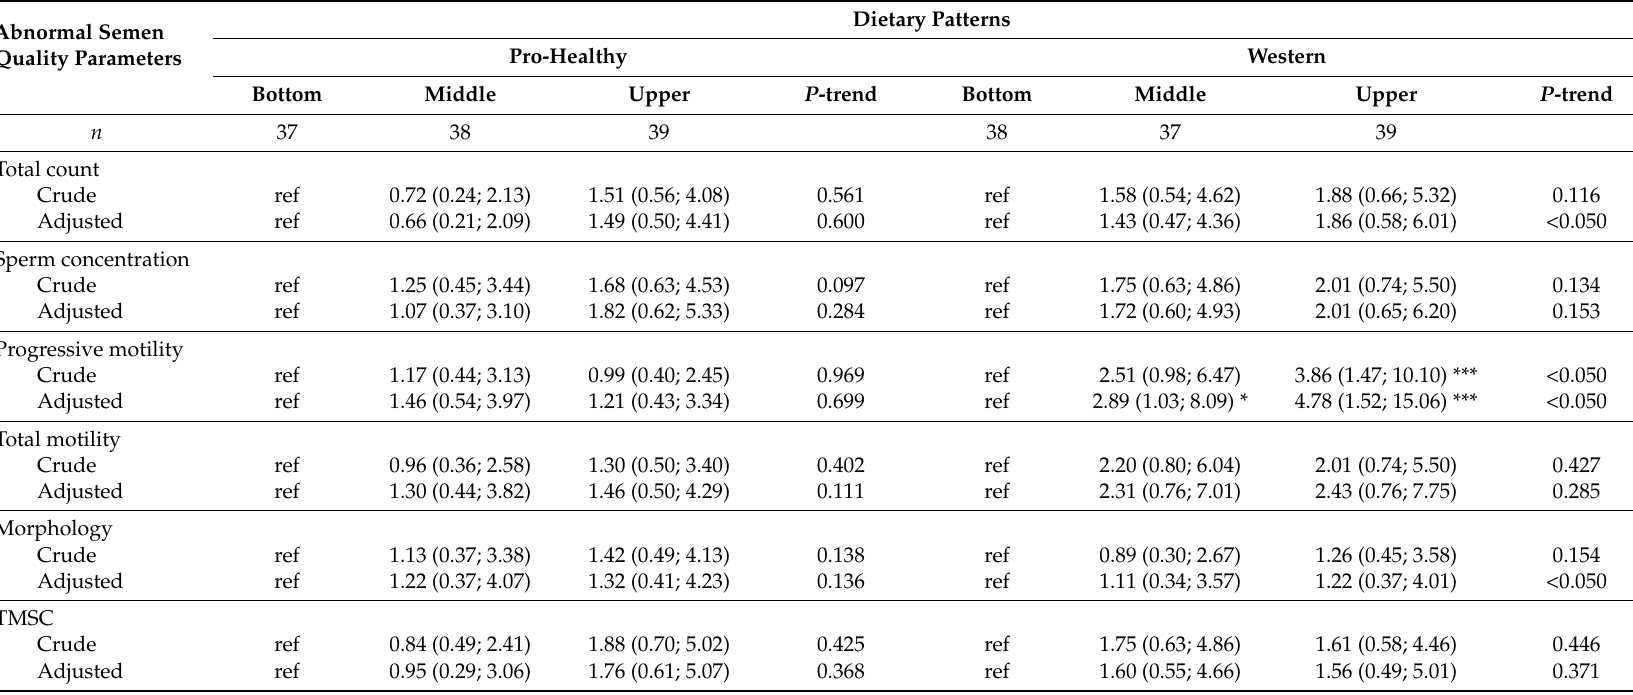
Table 4. Odds ratios (95% confidence intervals) for abnormal semen quality across tertiles of dietary